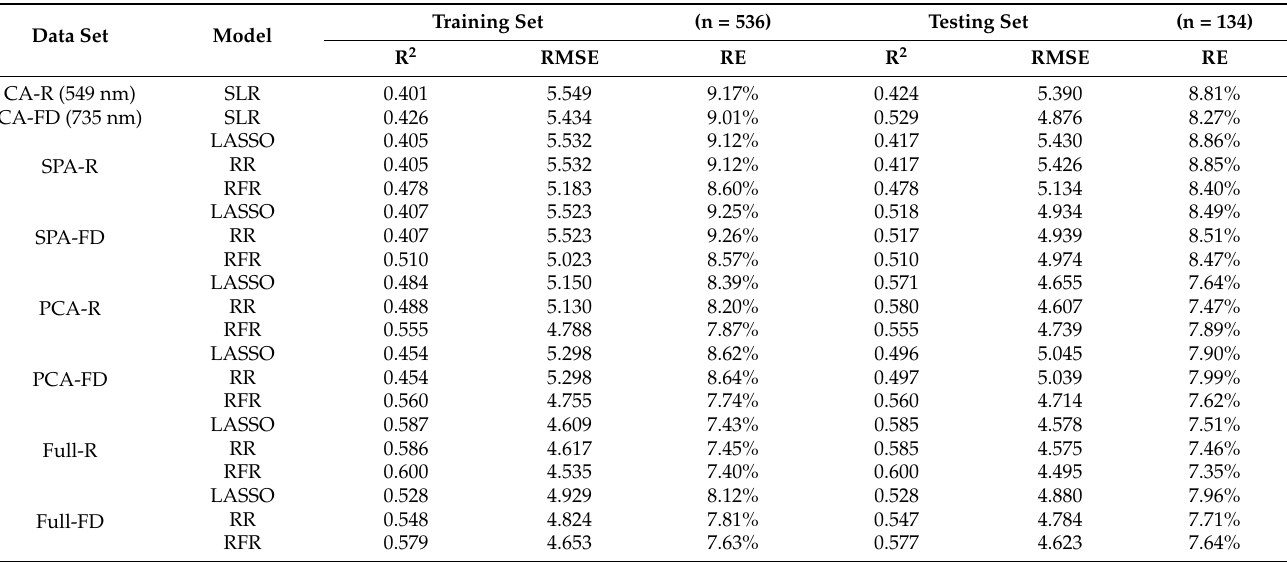
Table 1. The different models fitting results between SPAD and various spectral